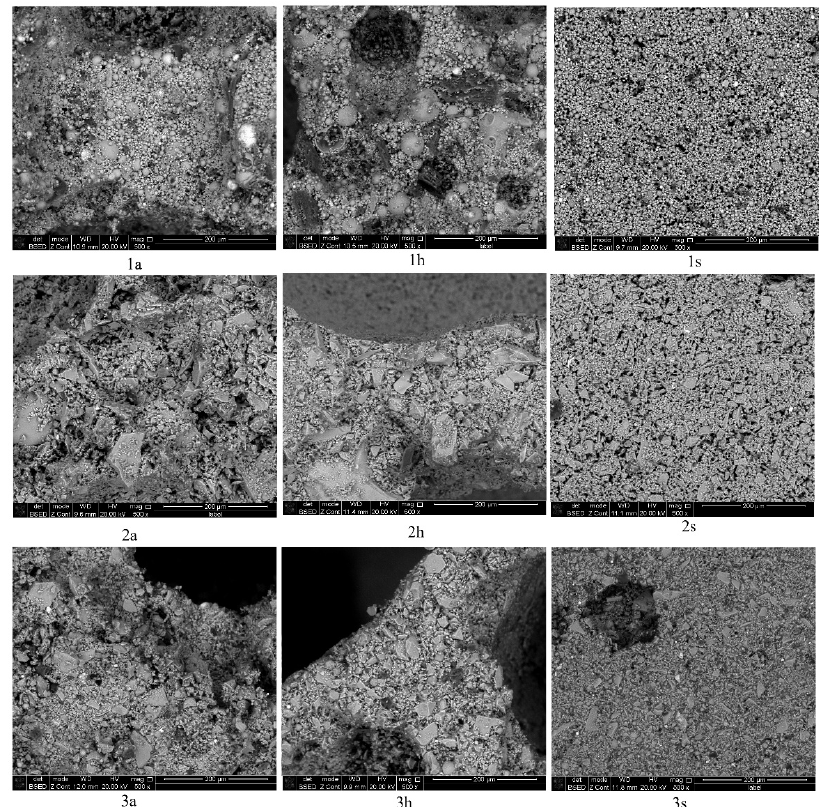
Figure 7. Microstructure of the studied geopolymers: 1—fly ash, 2—slag, 3—ash and slag mixture; a—aluminum powder, h—hydrogen peroxide, s—sodium hypochlorite.